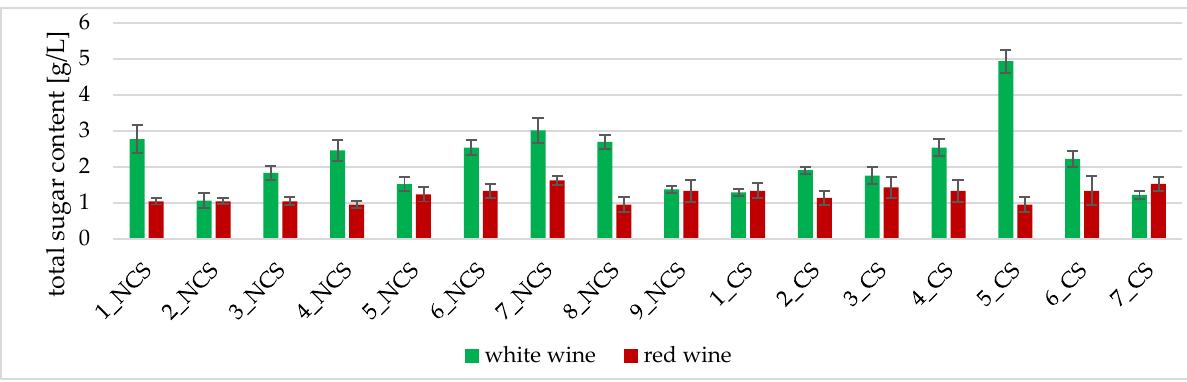
Figure 6. Total sugar content in wines of two vine varieties: white (Seyval blanc) and red (Regent) fermented with non-commercial (NCS) and commercial (CS) S. cerevisiae